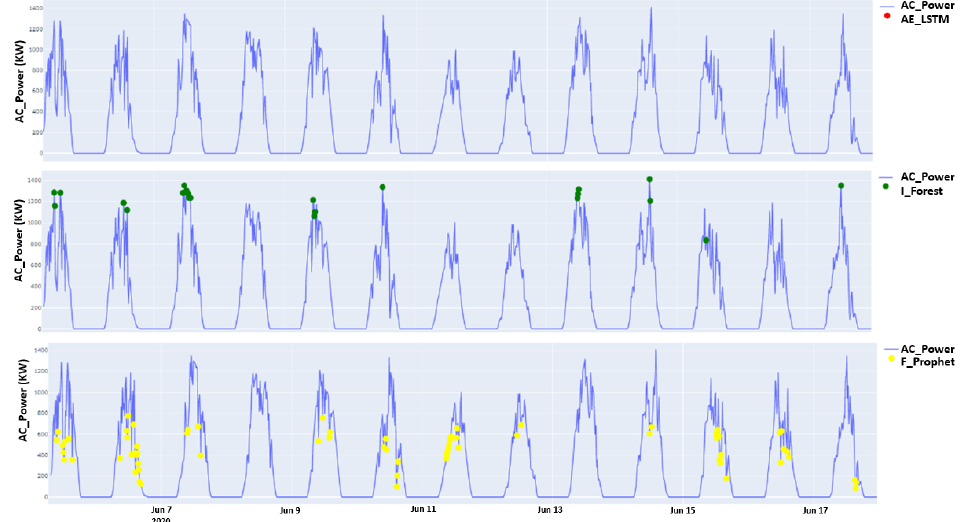
Figure 8. Anomaly detection outcomes from the three models on a healthy AC Power